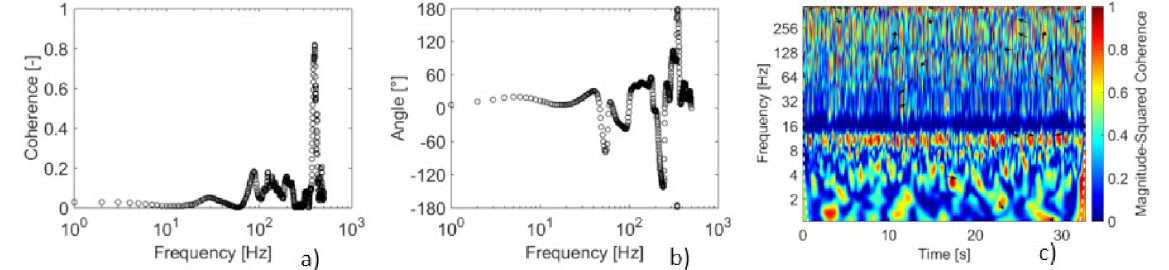
Figure 15. ( a ) Cross-coherence of the acceleration signals from both cylinders free to vibrate for reduced velocities equal to Vr C1 = 41 and Vr C2 = 23, ( b ) phase angle obtained in the cross-coherence, and ( c ) wavelet coherence of acceleration from the first cylinder and acceleration from the second cylinders free to vibrate for reduced velocities equal to Vr C1 = 41 and Vr C2 =